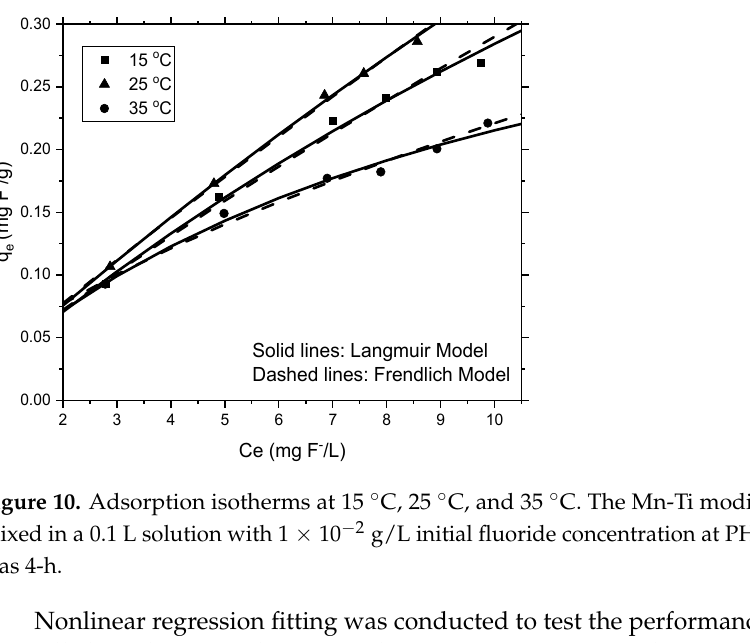
Figure 10. Adsorption isotherms at 15 °C, 25 °C, and 35 °C. The Mn-Ti modified zeolite (2 g) was mixed in a 0.1 L solution with 1 × 10 − 2 g/L initial fluoride concentration at PH = 9 and the test time was 4-h. Table 3. Fitted parameters of adsorption isotherms. Langmuir Model